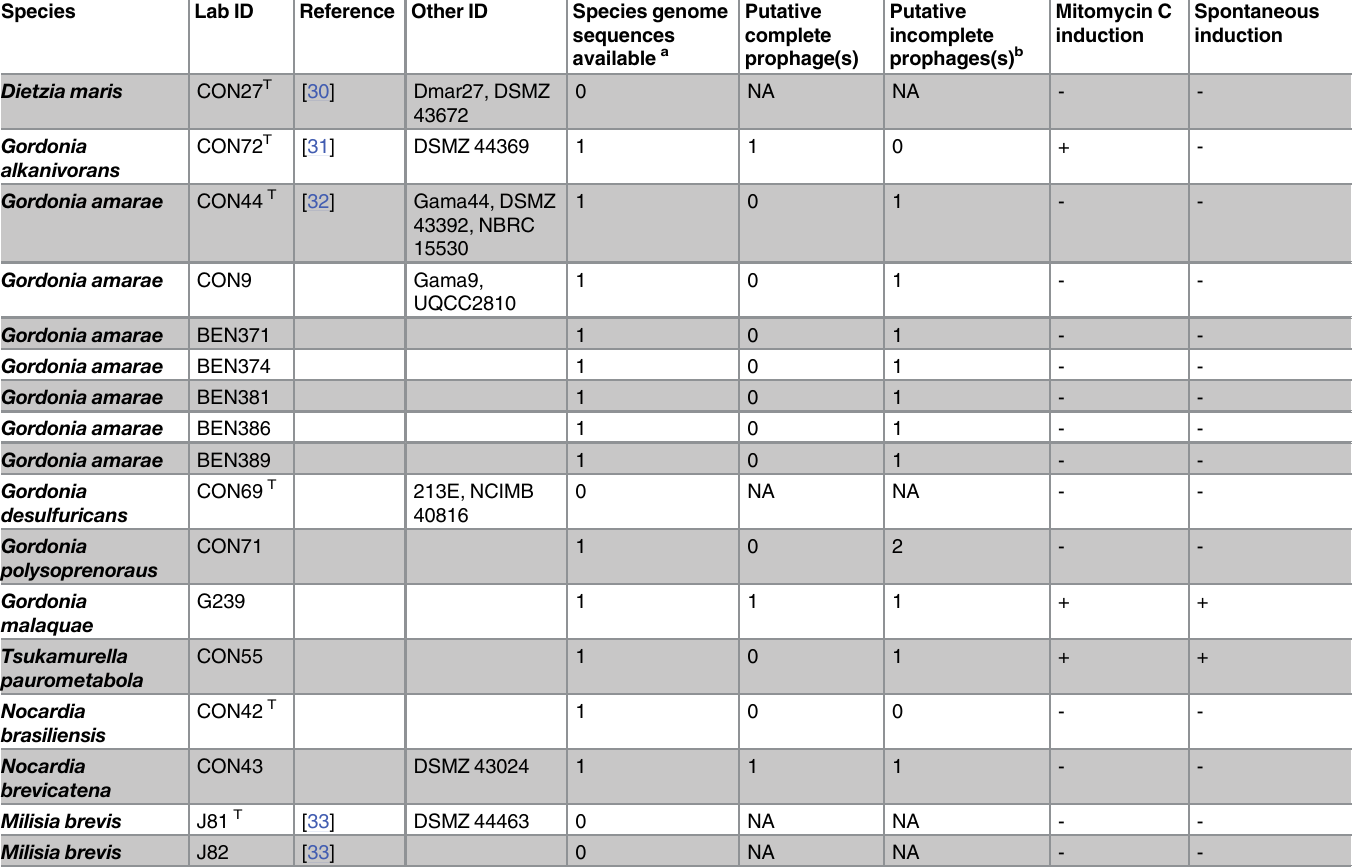
Table 1. Summary of strains used in Mycolata prophage induction studies.